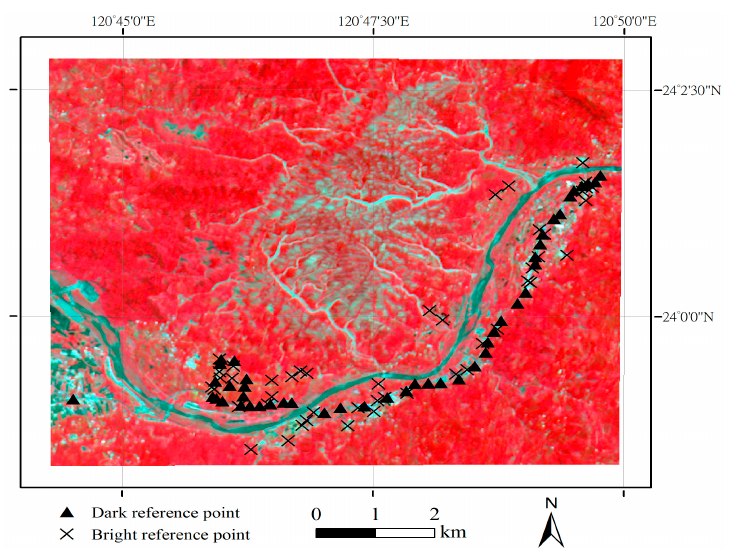
Figure 2. Selected pseudoinvariant features on satellite images.